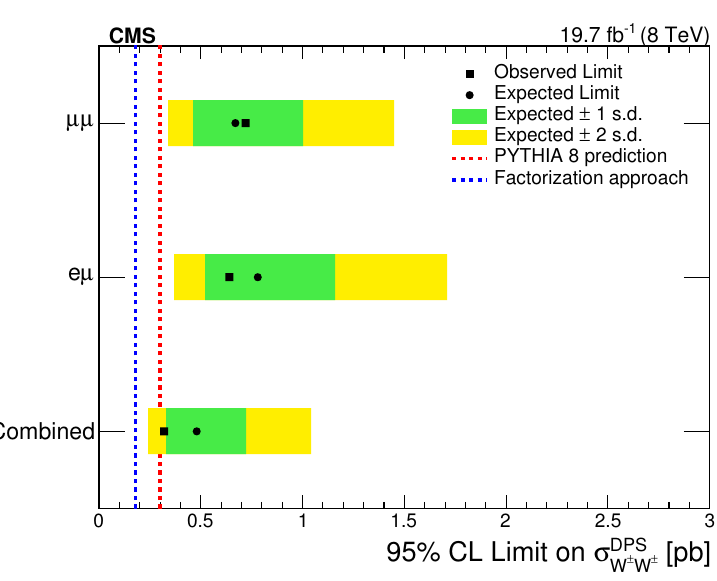
Figure 5 . Expected and observed 95% CL upper limits on the same-sign (cid:27) DPS and electron-muon (cid:12)nal states, along with their combination. The predicted values of (cid:27) DPS pythia 8 and from the factorization approach [21] are also